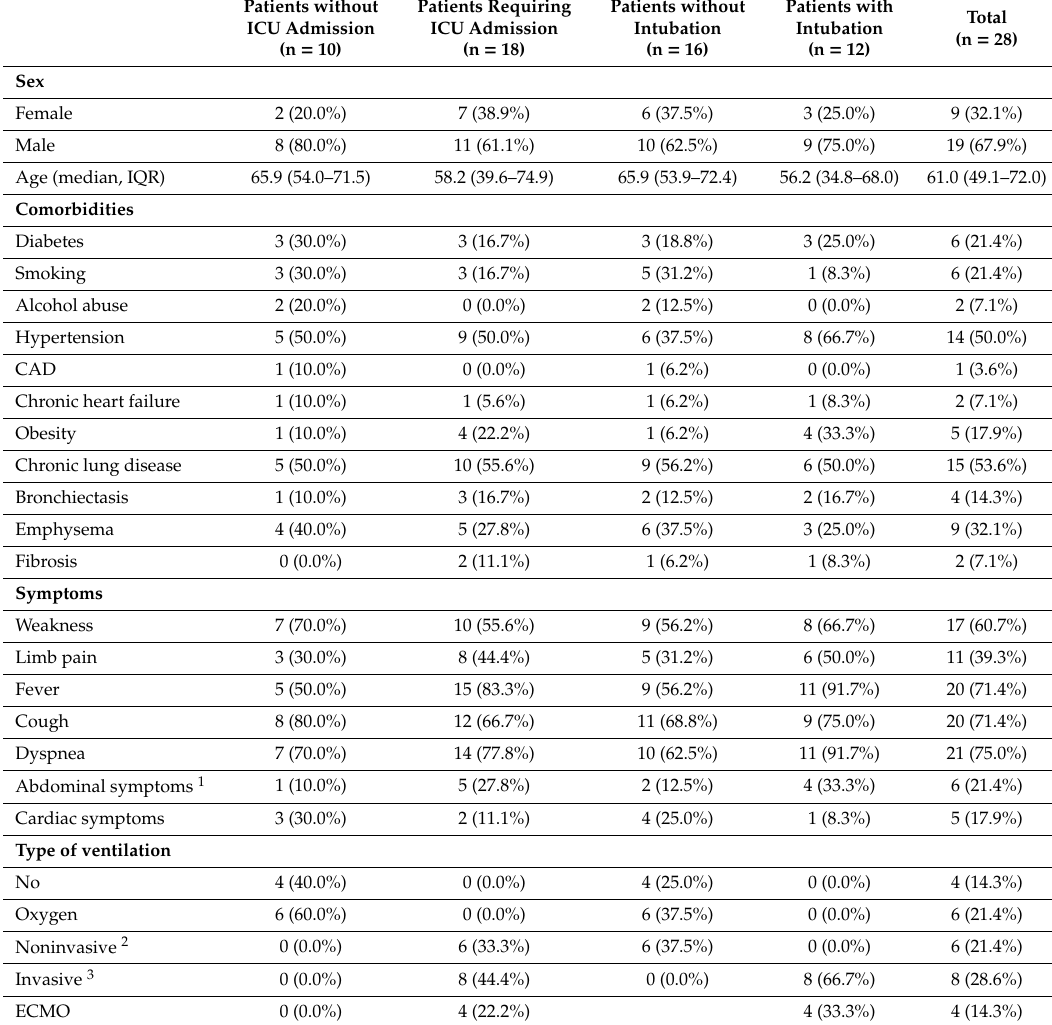
1 Abdominal symptoms: abdominal pain, diarrhea, nausea, cardiac symptoms: chest pain, angina pectoris. Oxygen—administration of oxygen through nasal cannula. 2 Noninvasive—noninvasive ventilation via CPAP